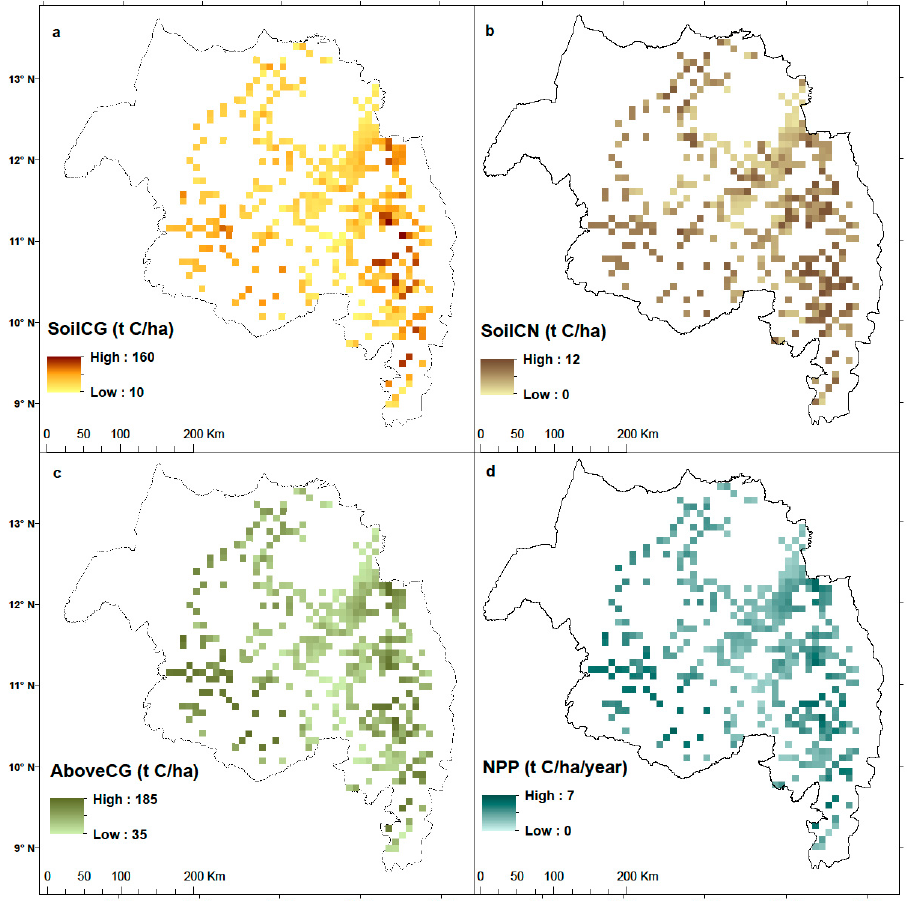
Figure 4. Spatial distributions of predicted soil and aboveground carbon and annual NPP 100 years after reforestation (unthinned) for the selected reforestation areas on the 9 km by 9 km resolution. ( a ) SoilC G —Gross soil carbon stock (t C ha − 1 ); ( b ) SoilC N —Net soil carbon stock (t C ha − 1 ), calculated as the difference between SoilC G and the initial soil carbon stock SoilC I (compare Tables 1 and 3); ( c ) AboveC G —Gross aboveground carbon stock (t C ha − 1 year − 1 ); ( d ) annual net primary production (NPP, 10-year mean, years 91–100 after reforestation).